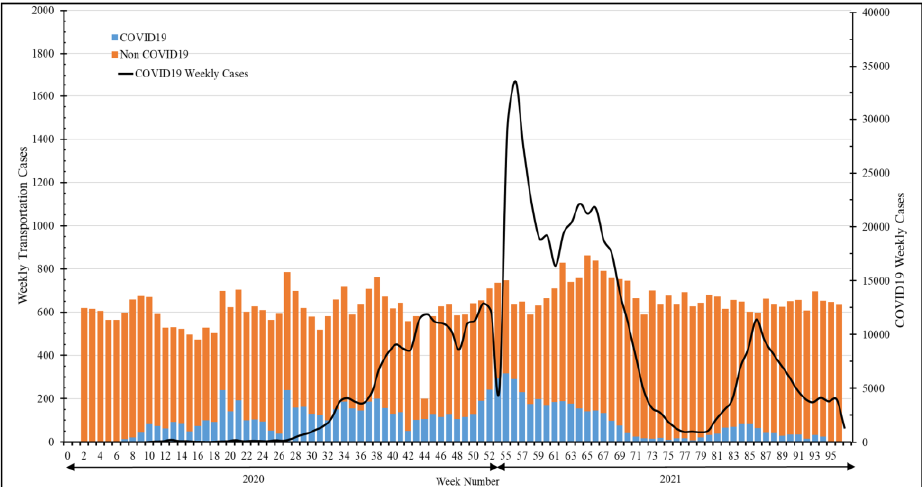
Fig. 4. Weekly Emergency Missions for 2020 and 2021 – COVID-19 and Non COVID-19 Cases